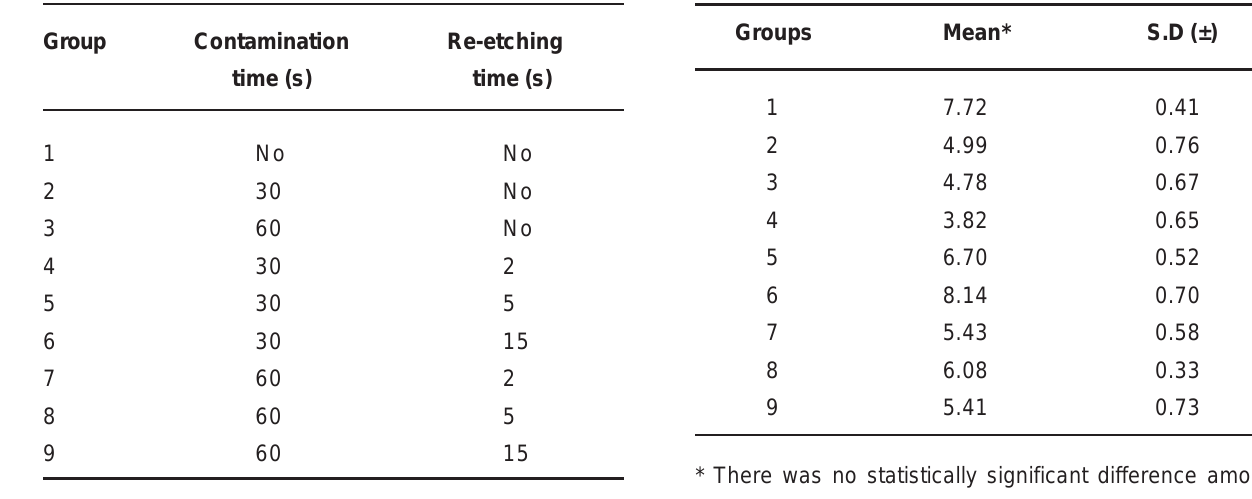
TABLE 1- Distribution of the groups according to saliva contamination and re-etching times